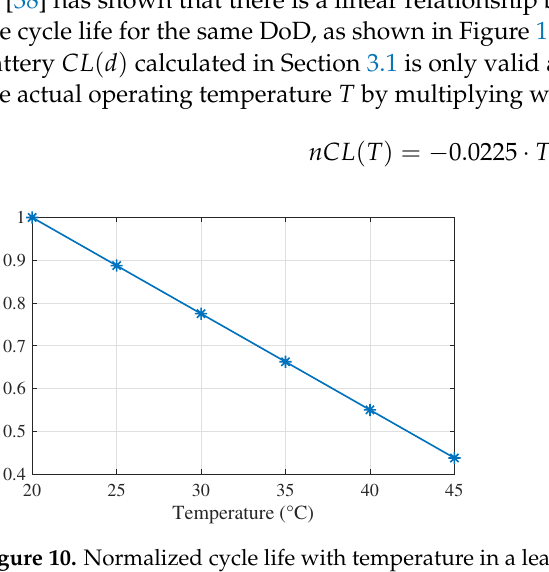
Figure 10. Normalized cycle life with temperature in a lead–acid battery